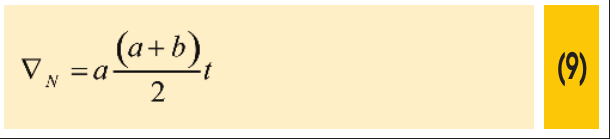
Figure 10 – Variation of the parameter  for 3 meters story height